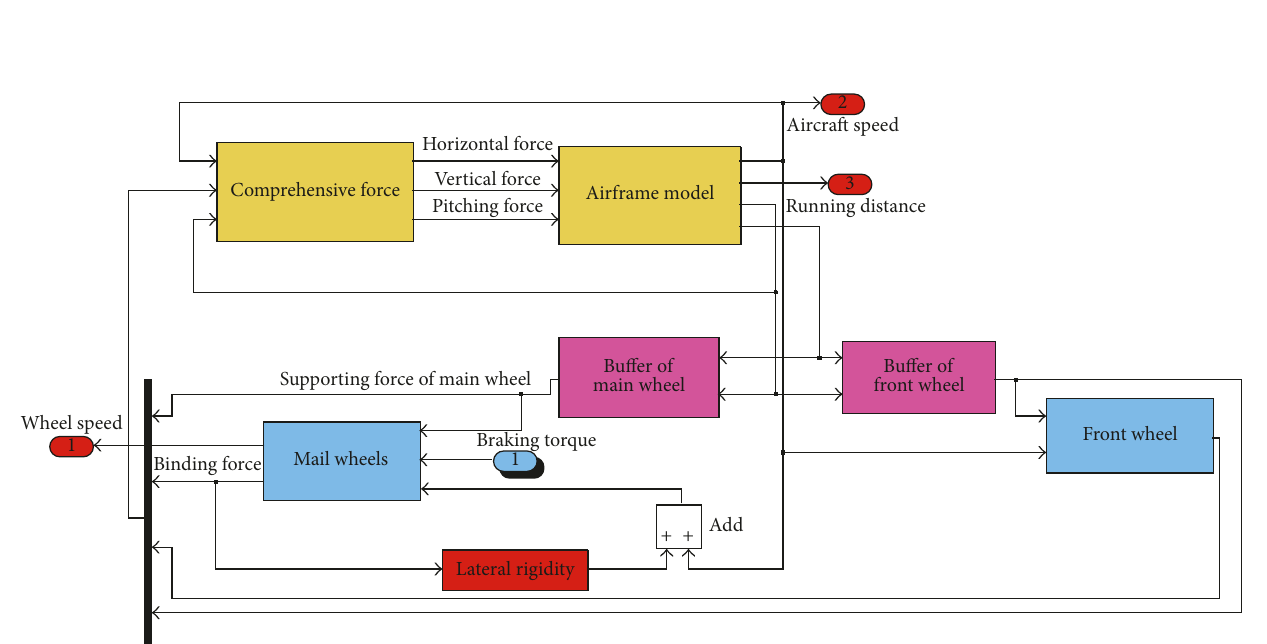
Figure 6: The simulation model of